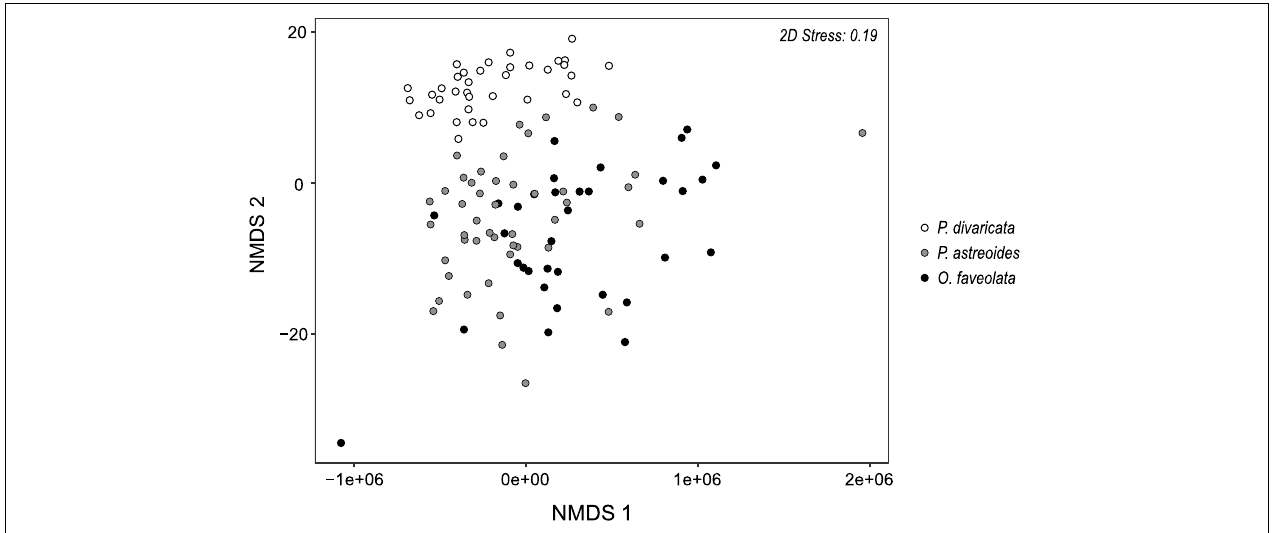
groups for each physiological trait were compared by Tukey Post hoc